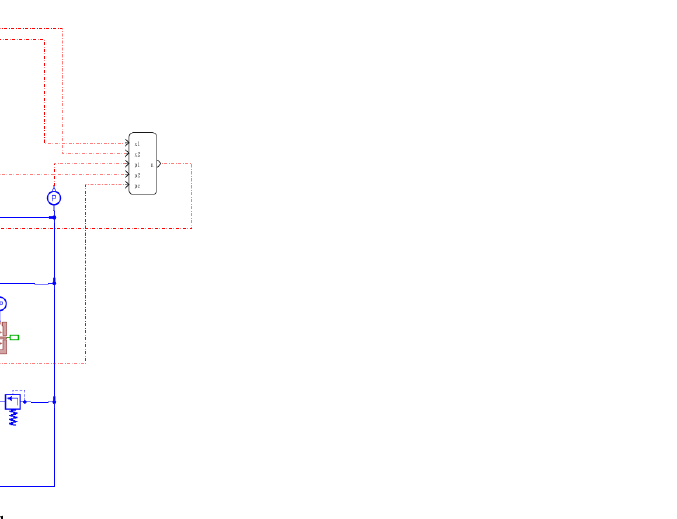
Figure 2. AMESim model.